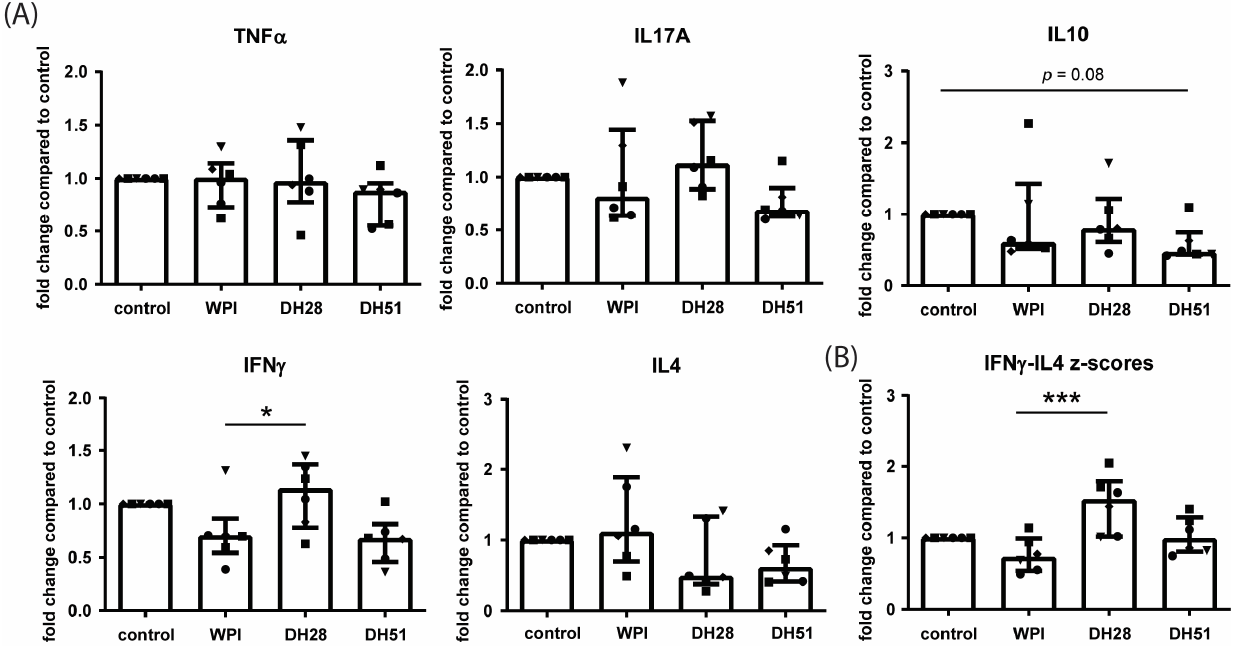
Figure 11. mRNA expression of various cytokines in T cell-activated PBMCs following incubation with WPI, DH28, or DH51. ( A ) mRNA expression of TNF α (Th1 cytokine), IL17A (Th17 cytokine), IL-10 (regulatory T cell cytokine), IFN γ (Th1 cytokine) and IL4 (Th2 cytokine) in T cell-activated PBMCs incubated with or without WPI, DH28 or DH51 for 5 days. Data are reported as relative expression compared to control (set at 1) and displayed as median with interquartile range. Results were obtained from four different PBMC donors (depicted by different data point symbols, one symbol type per donor). * p ≤ 0.05. ( B ) mRNA expression of IFN γ relative to IL4 (IFN γ -IL4 z-scores, Th1-Th2 balance) in T cell- activated PBMCs incubated with or without WPI, DH28, or DH51 for 5 days. Data are reported as relative expression compared to control (set at 1) and displayed as me- dian with interquartile range. Results were obtained from four different PBMC donors (depicted by different data point symbols, one symbol type per donor). *** p ≤ 0.001 Abbreviations: TNF α —tumor